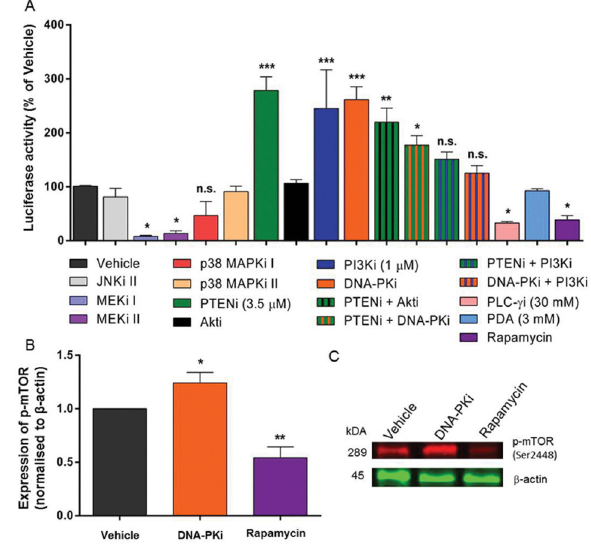
Figure 3. Activation of PI3K and PIKK signaling pathways induces Lmx1a reporter gene expression. Panel A shows the luciferase activity from Lmx1a - luc mESCs on day 8, after incubation with combinations of SMAs from day 4-8. PD169316 and SB220025 are inhibitors of p38 MAPK pathway whereas U-73122 specifically inhibits PLC-γ signaling. Solid colored columns represent incubations with single SMAs whereas striped columns depict combination incubation of